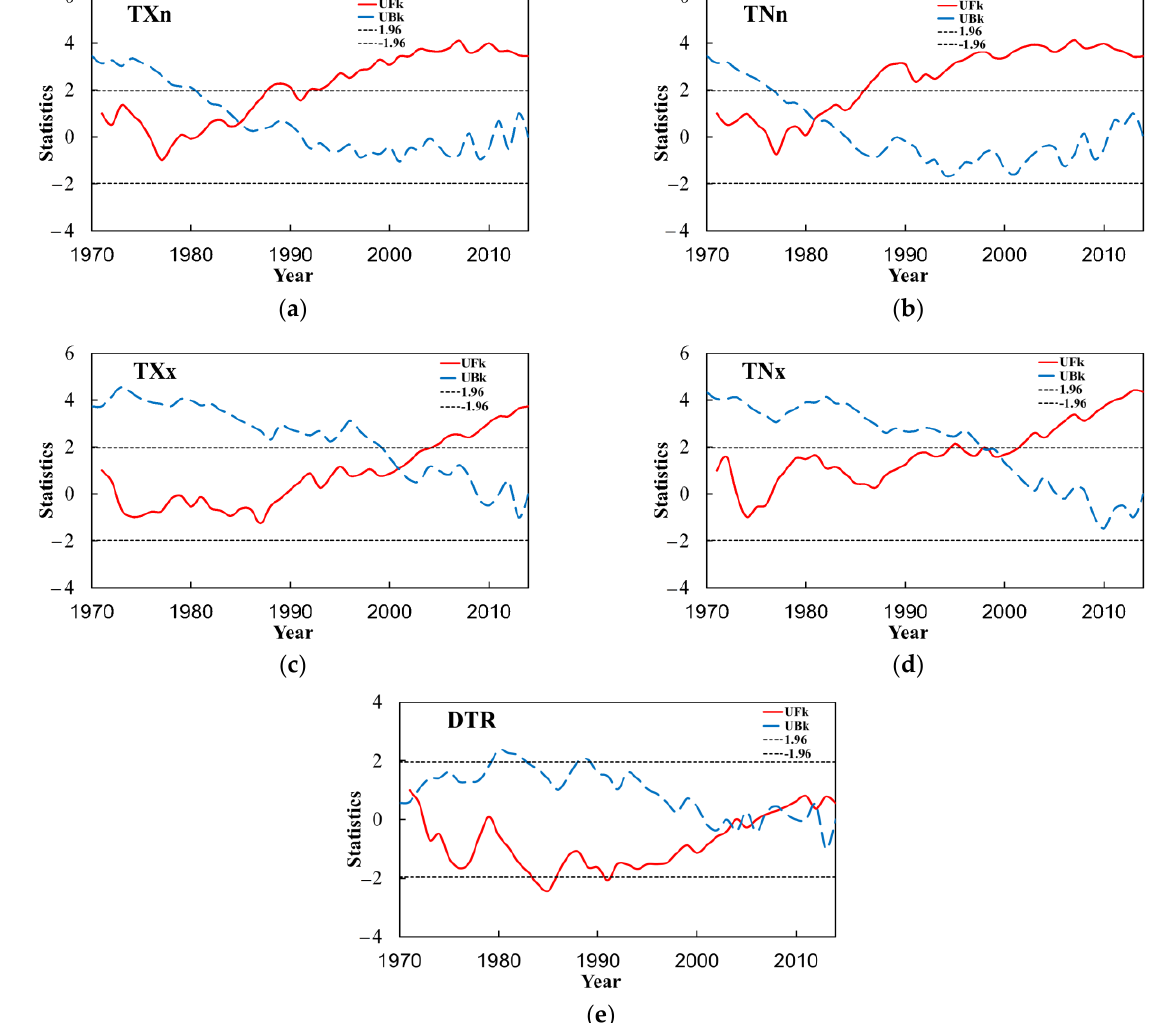
Figure 10. M – K abrupt change test of the extremal indices of extreme temperatures in the Yangtze River Basin from 1970 to 2014. ( a ) is TXn, ( b ) is TNn, ( c ) is TXx, ( d ) is TNx and ( e ) is DTR.